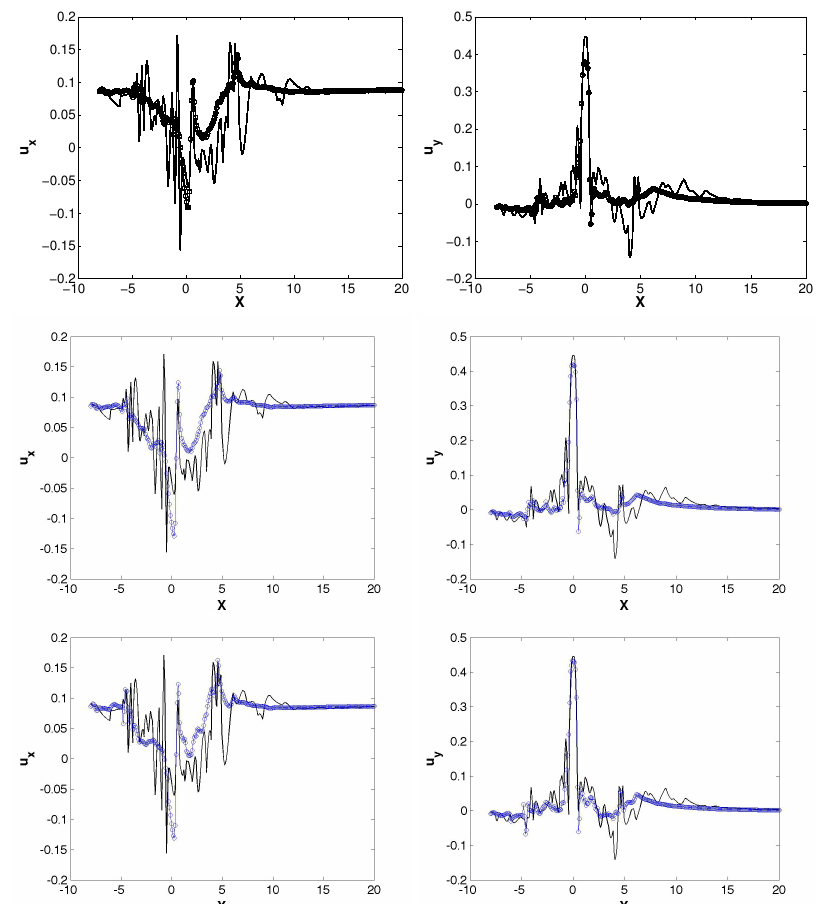
Figure 16. Counterpart of Figure 7 in the three-blades turbine applying HODMD in 145 snapshots starting at time 25.604 s. Data extracted at y = − 4 m.